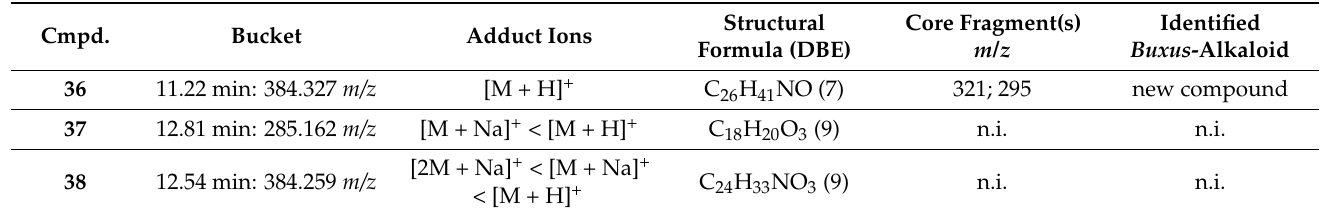
Figure 9. Volcano plot of the comparison of the twig with the leaf extracts. Buckets with a high fold change |log 2 (fold change) | ≥ 2 and a low p -value ≤ 0.05 ( − log 10 ( p ) ≥ 1.3) are shown in yellow. Assignment of compounds that are present in higher concentrations in the twig extracts compared to the leaf extracts. * Structural assignment based only on mass spectral data; stereochemistry tentatively assumed in analogy with known compounds [3]. Table 5. LC/MS-characteristics of compounds displaying a high fold change and a low p -value (compare Figure 9). Cmpd.